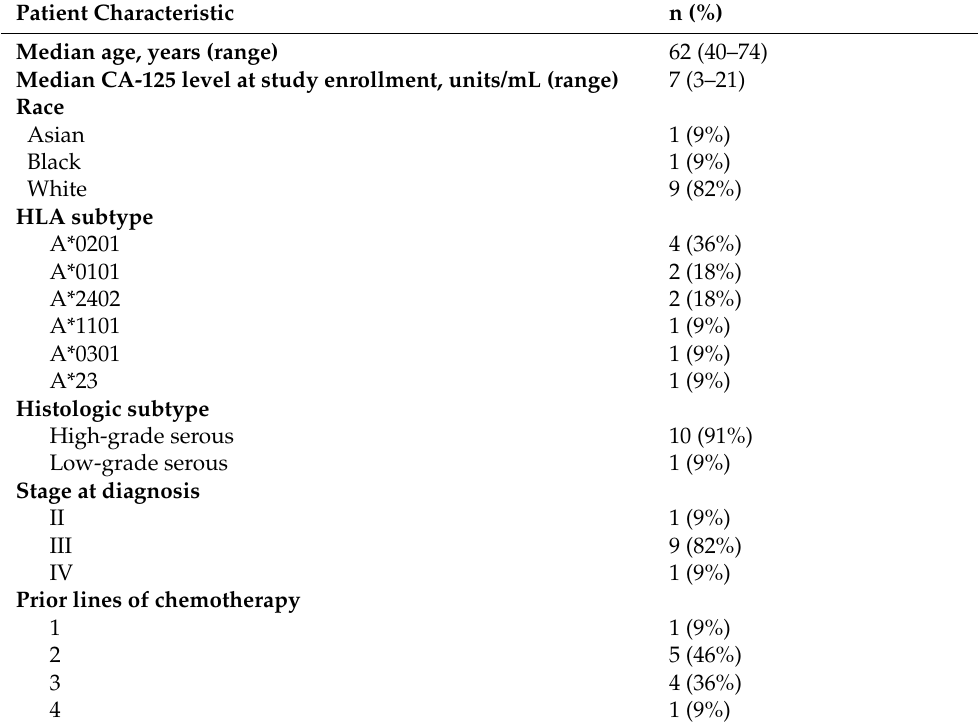
Table 1. Study population (N =